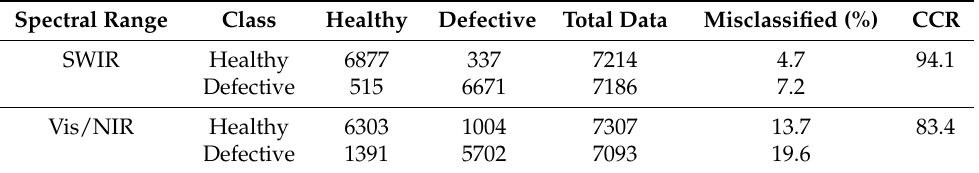
Table 2. Evaluation of the performance of the MV classifier using the confusion matrix, the error rate per class, and the CCR, after 200 train/test